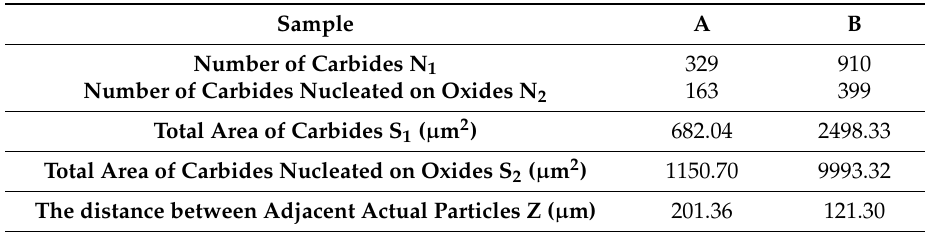
Table 6. Number, total area of particles, and the distance between adjacent actual particles for samples A and